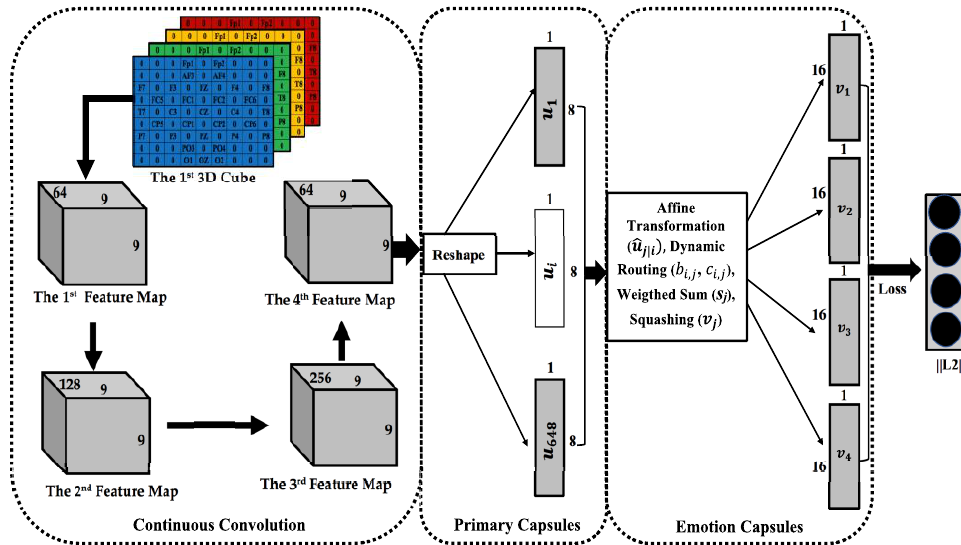
Figure 4. Continuous Capsule Network architecture for four